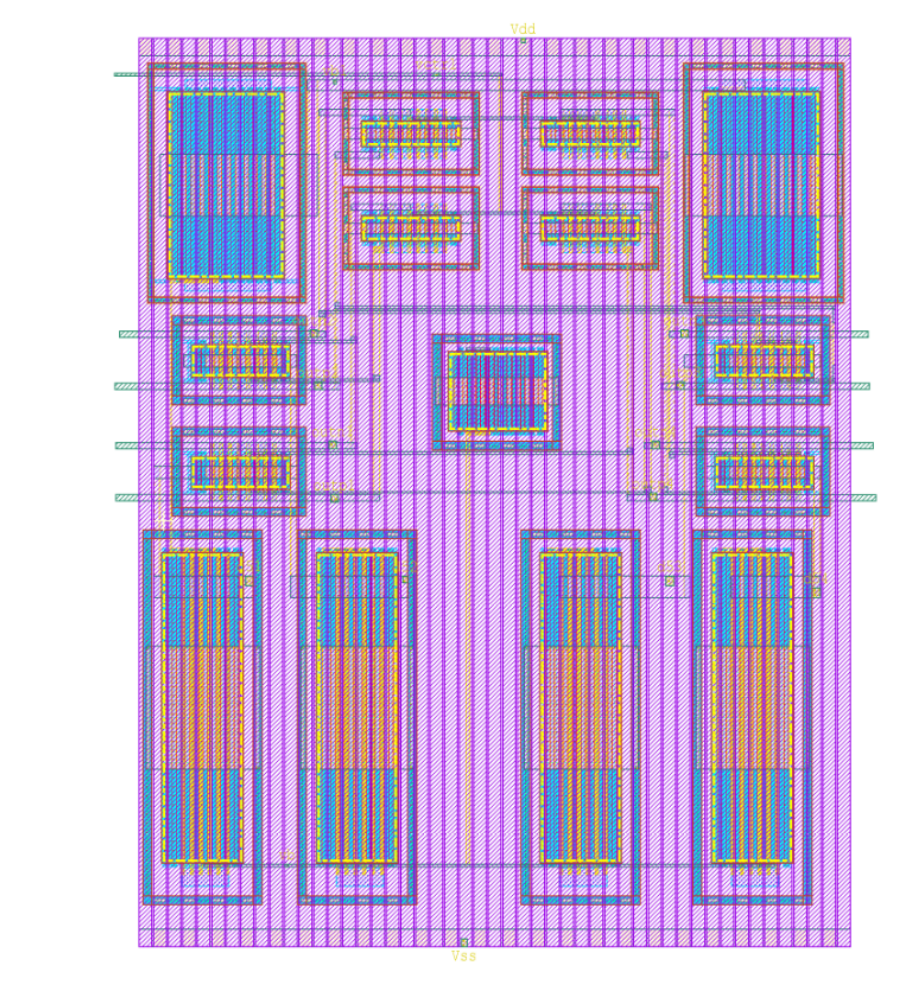
Figure 17. Complete layout of the VCO based on four CMOS differential stages, implemented in Tanner from Mentor graphics using UMC technology of 180